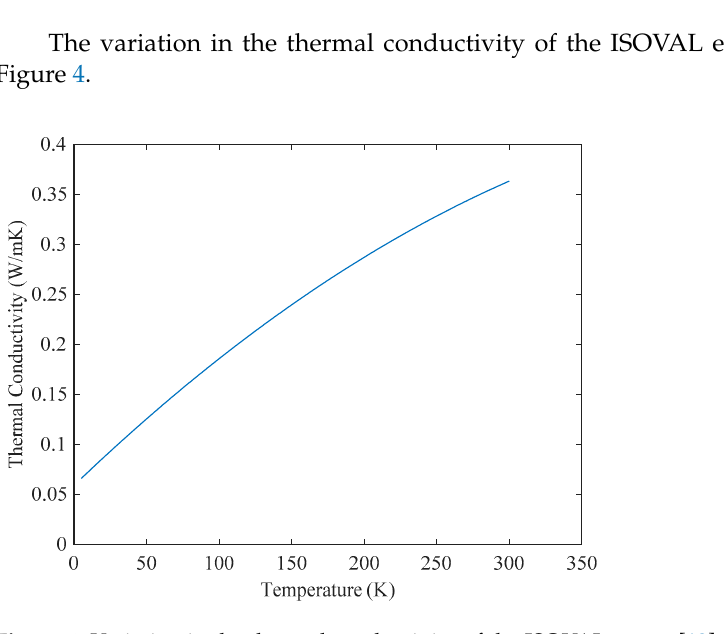
Figure 4. Variation in the thermal conductivity of the ISOVAL epoxy [12].